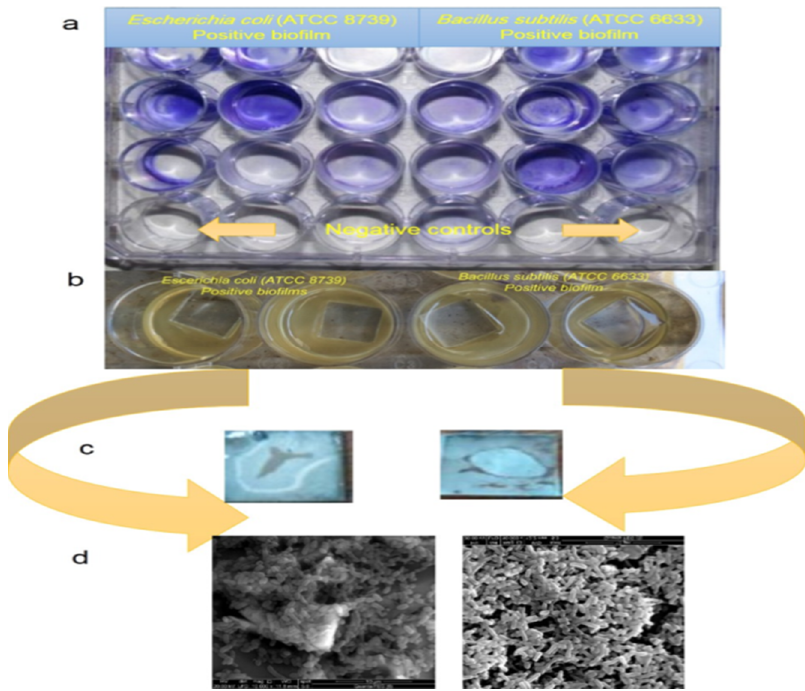
Figure 3. Positive induced bacterial biofilms of Bacillus subtilis (ATCC 6633) and Escherichia coli (ATCC 8739) on a 24 dilution titer plates. ( a ) the cultivated biofilms on the plate surface, ( b ) the cultivated biofilms on the glass surface (1.0 × 1.0 × 0.3 cm), ( c ) the dried biofilms on the glass surface, ( d ) the scanning electron microscopy (SEM) images of Bacillus subtilis (ATCC 6633) (right side) and Escherichia coli (ATCC 8739) (left side).